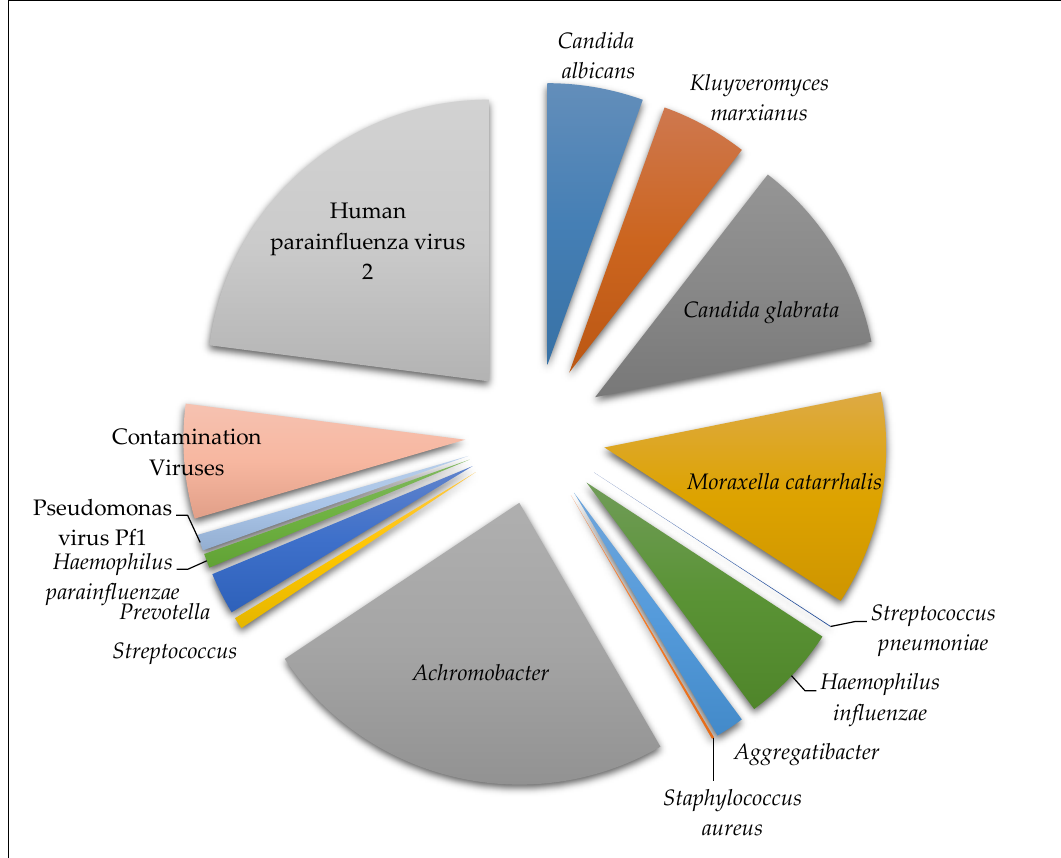
Figure 3. Distribution of microorganisms in sample 1: the filtered microbes plus the confirmed unfiltered pathogens with frequencies generated from the CosmosID app. The group labeled “contamination viruses” comprises viruses found in the negative control.